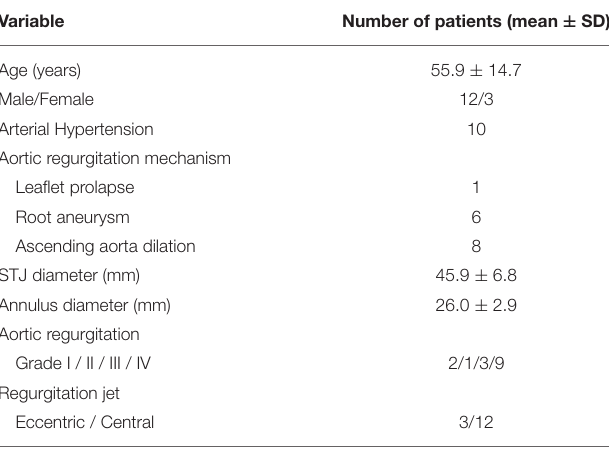
TABLE 2 | Pre-operative characteristics of 15